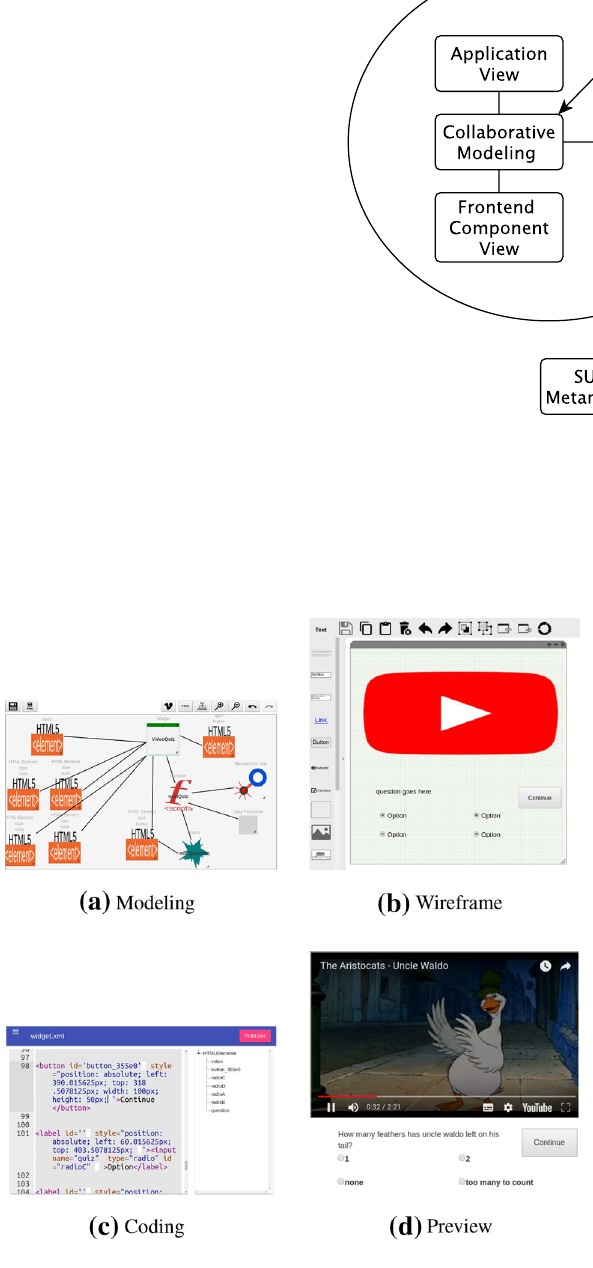
Fig. 2 Overview of the MDWE approach